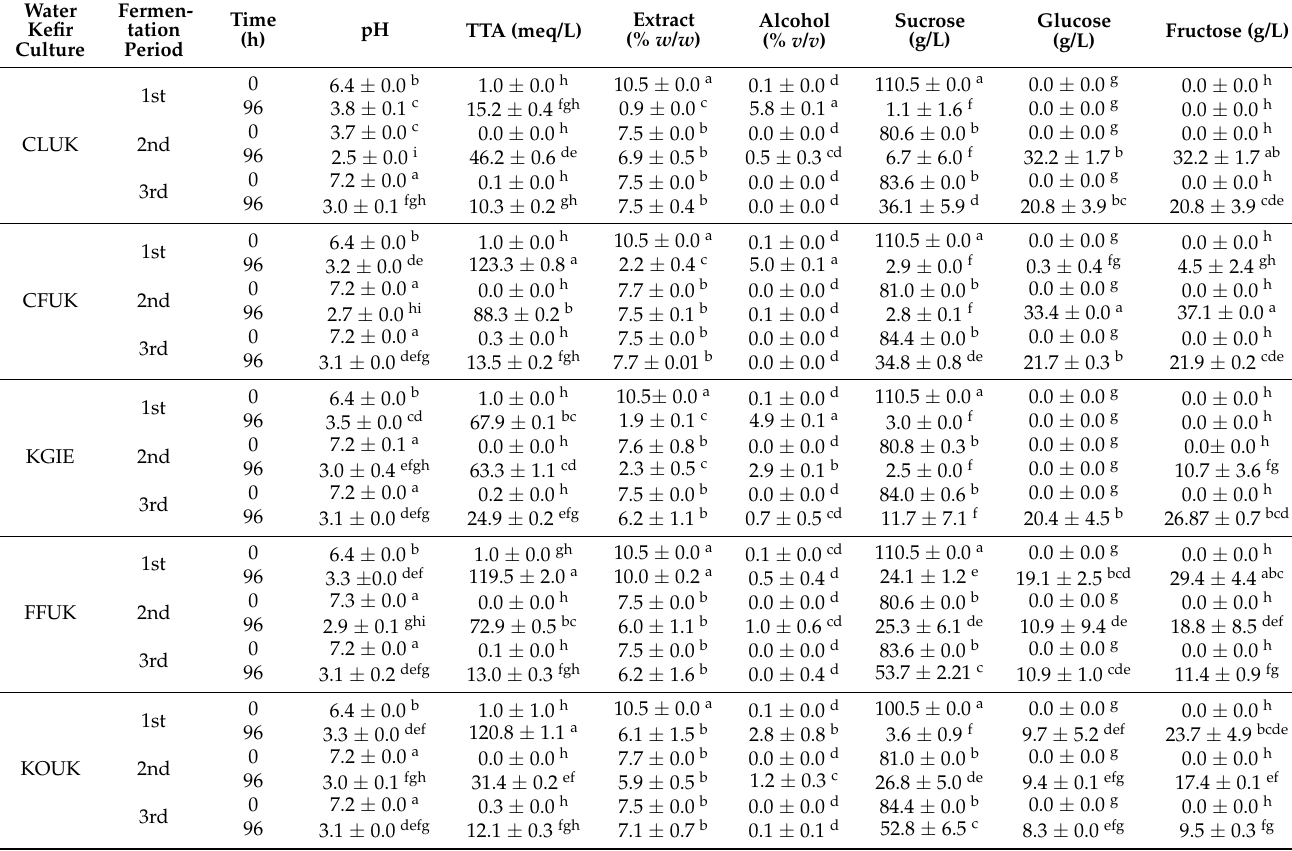
Table 3. Characteristics of water kefir fermentations performed under nitrogen limitation.